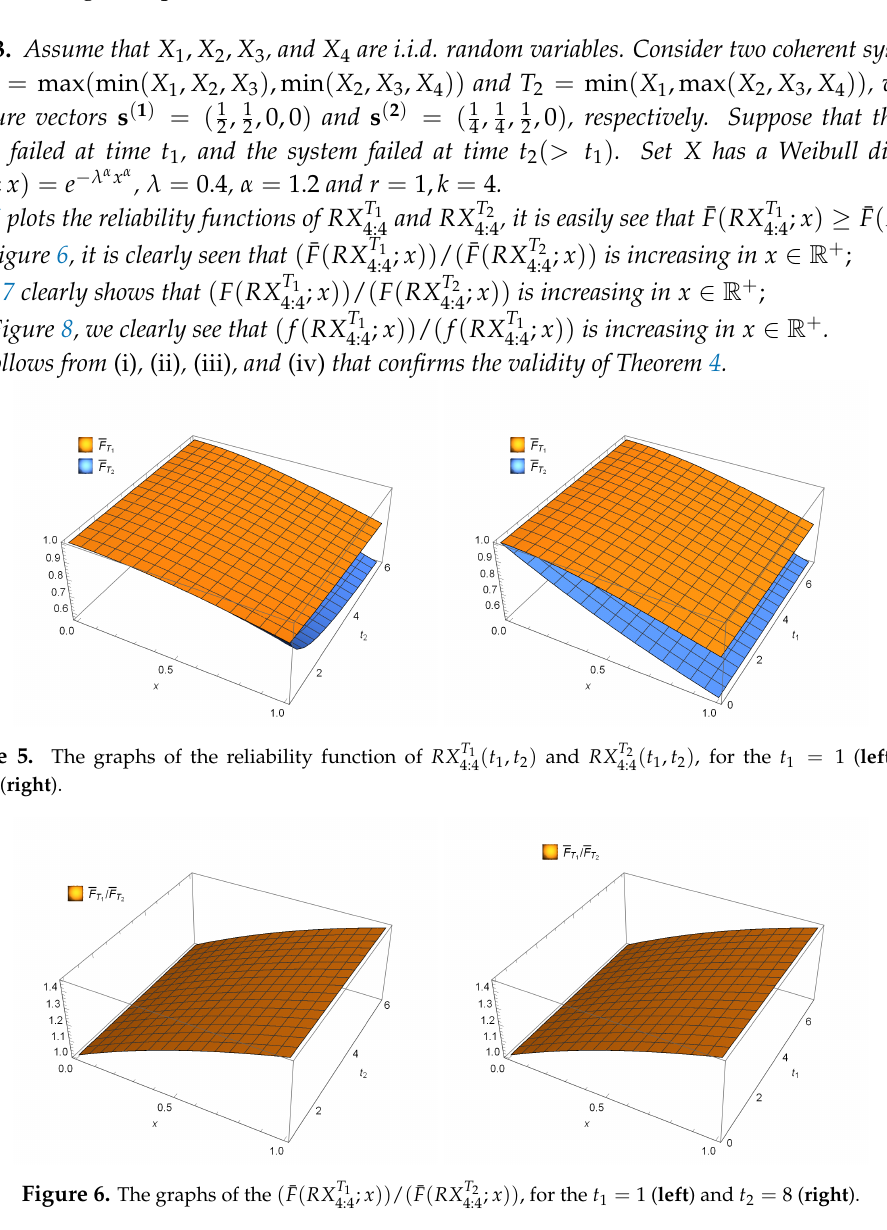
; x )) / ( ¯ F ( RX T 2 ; x )) , for the t 1 = 1 ( left ) and t 2 = 8 ( right 4:4 4:4